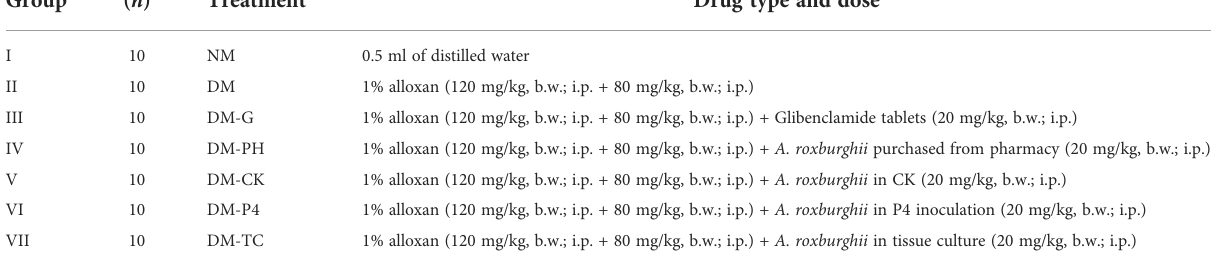
TABLE 1 Grouping and feeding of experimental mice. Group ( n ) Treatment Drug type and